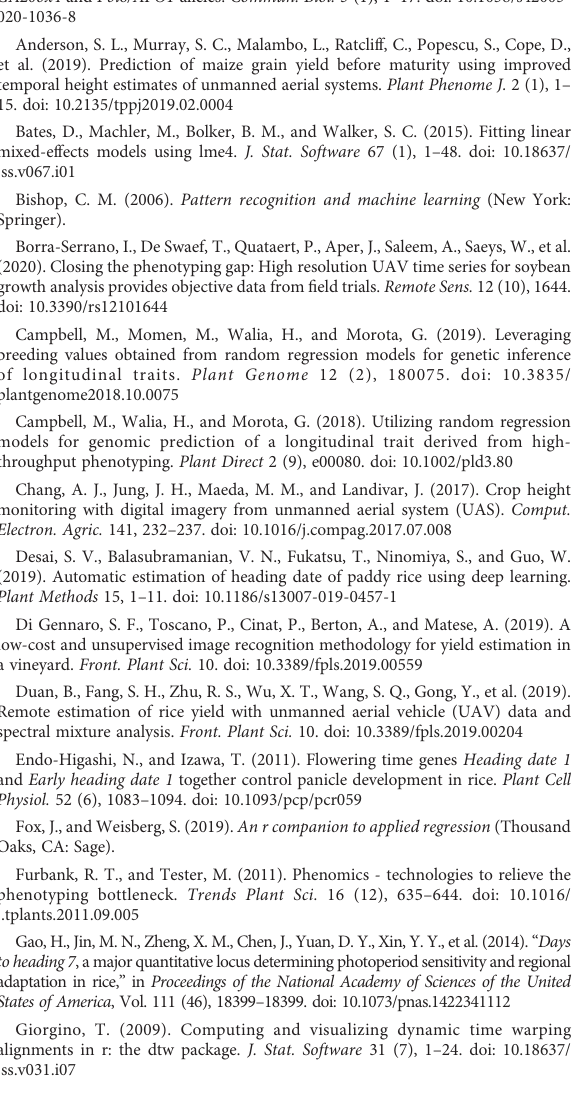
SUPPLEMENTARY FIGURE 1 Trajectory of each CH time-series curve. The LME model calculated the cultivar effects of each CH-related parameter, which generated the cultivar-speci fi c time-series curve ( “ Cultivar E ” ). SUPPLEMENTARY FIGURE 2 Correlation plot of parameters and traits in (A) 2020 and (B) 2021. Values are correlation coef fi cients (cor); circles present them by color and size. SUPPLEMENTARY FIGURE 3 Visualization of the LME model for GW. Left, proportion of 4 variance components; right top, BLUPs of cultivar and cultivar × year interactions of 30 cultivars; right bottom, BLUPs of 3 years. Cultivars are sorted by d 1 .